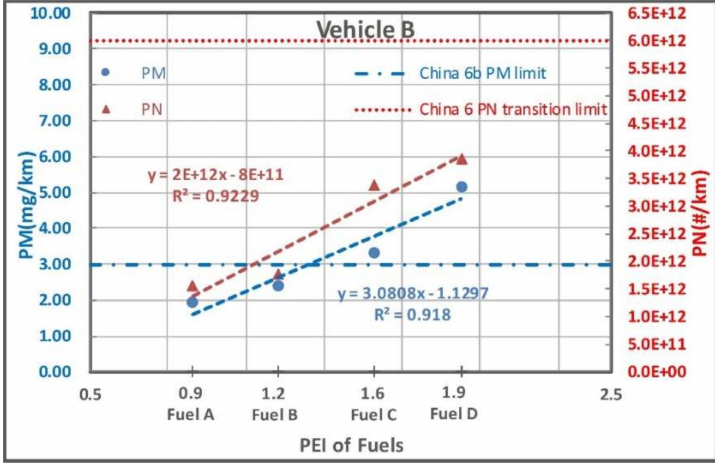
Figure 8. PEI vs. PM and PN emissions from Vehicle B.